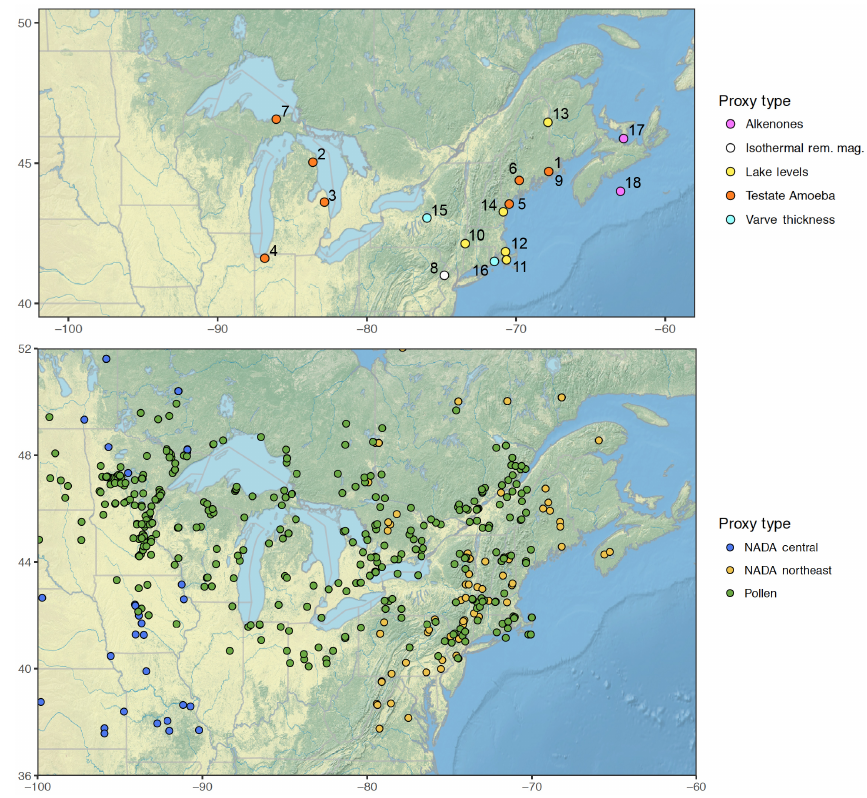
Figure 1. Locations of sites (see Table 1 for upper panel site index) with paleoclimate data used in this paper that span at least 2 centuries reconstructed from various sources in the northeastern US. Isothermal rem. mag. is isothermal remanent magnetization; NADA is the North American Drought